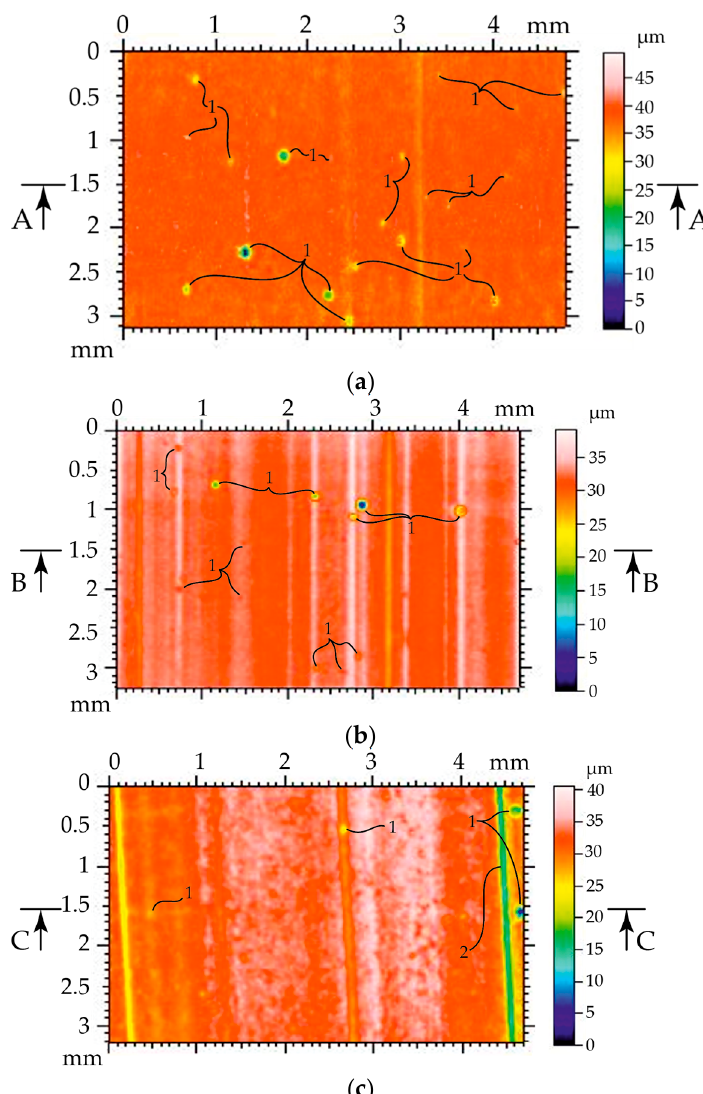
Figure 5. Measurements and graphical representation of the surface roughness carried out using the Hommel Tester T8000: ( a )—EDM1; ( b )—EDM2; ( c )—EDM3; 1—crater; 2—wire breakage.